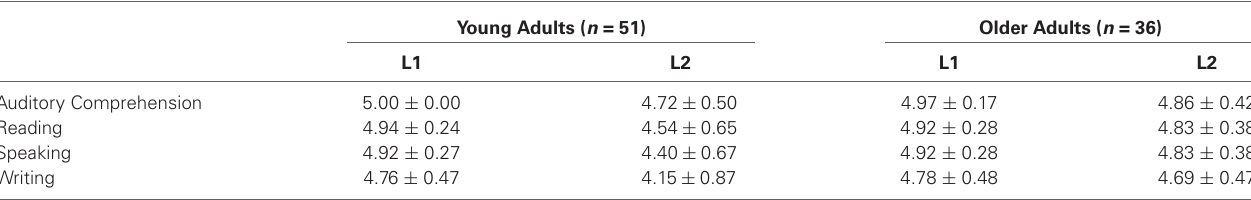
Table 1 | Mean ranking ( ± standard deviation) for proficiency by modality for both L1 and L2 for bilingual participants